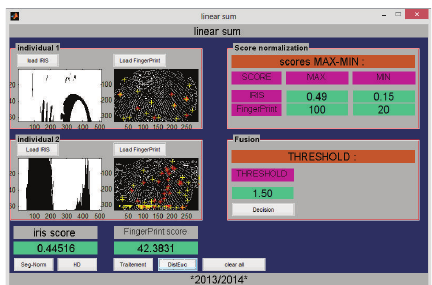
Figure 11: GUI showing the matching using the fusion by the sum rule.